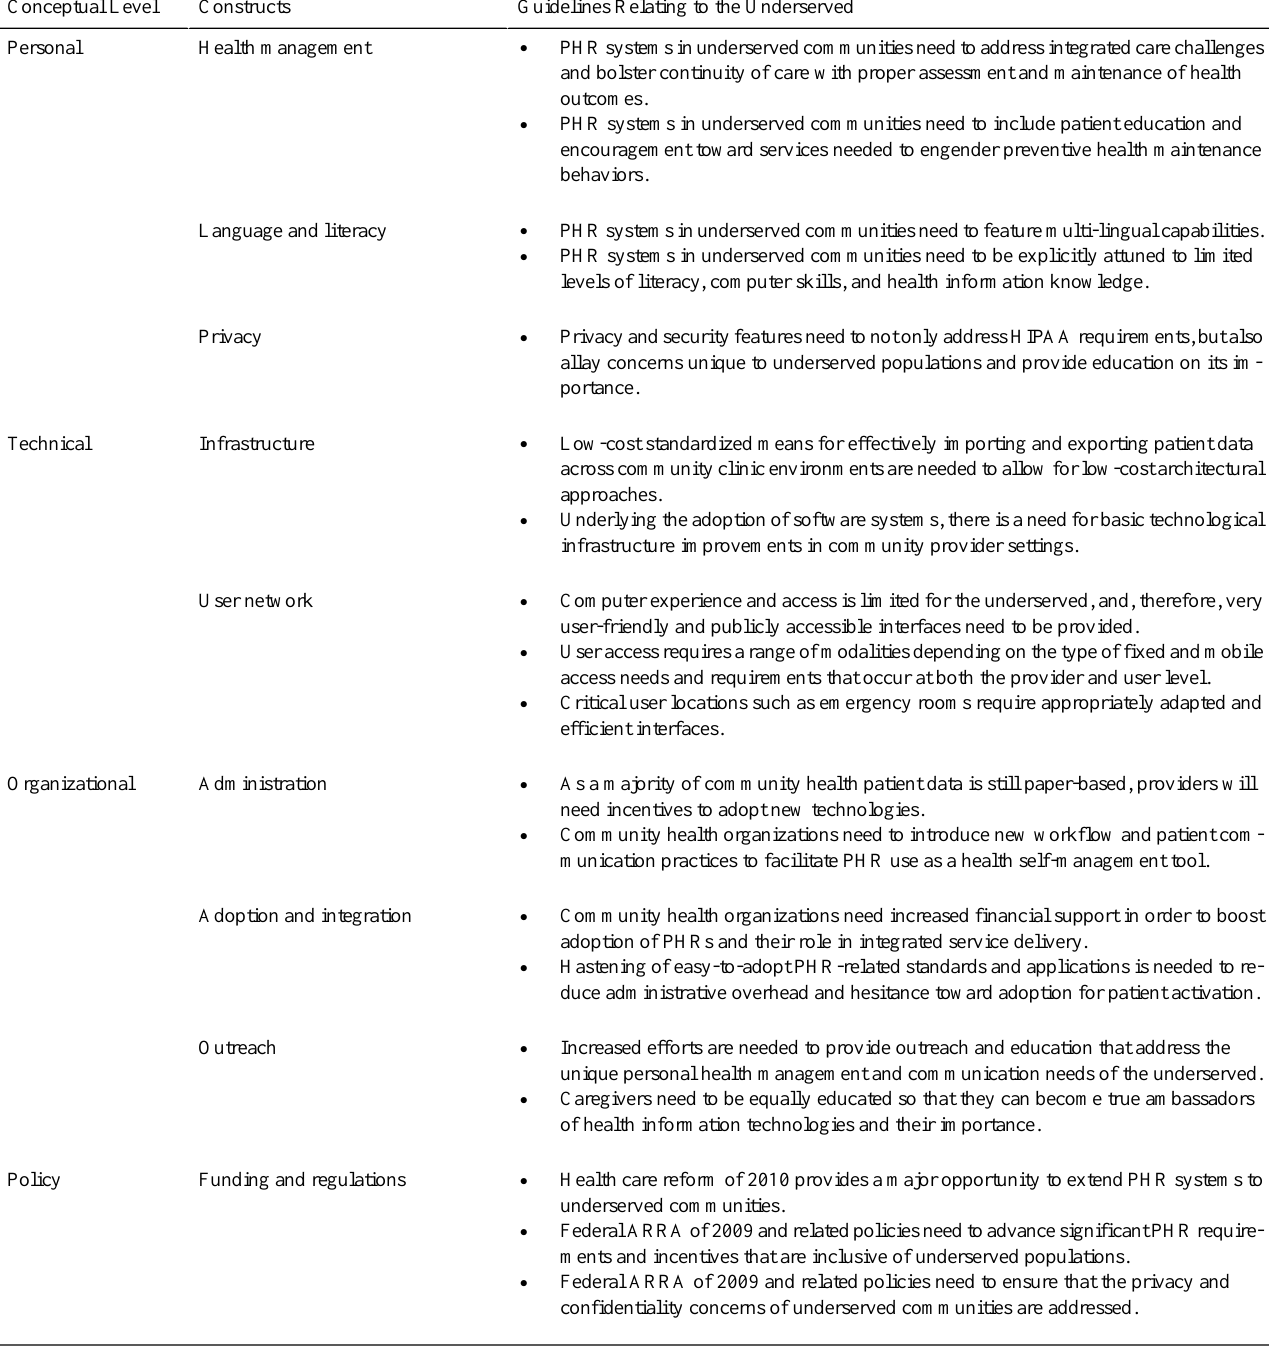
Table 1. Framework for PHR systems in underserved